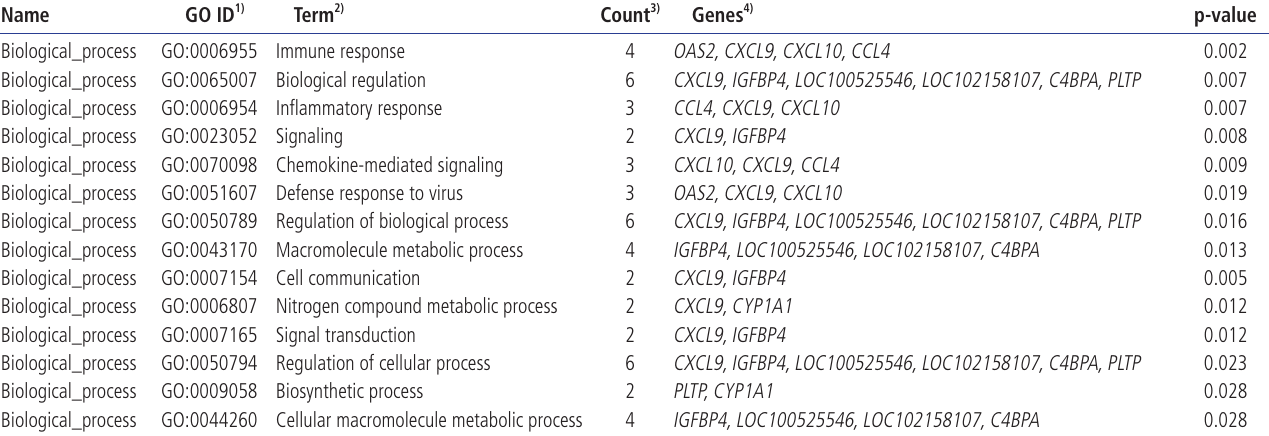
Table 1. Top biological process GO terms of DEGs, obtained from the comparison between the control group and DON- and ZEN-treated